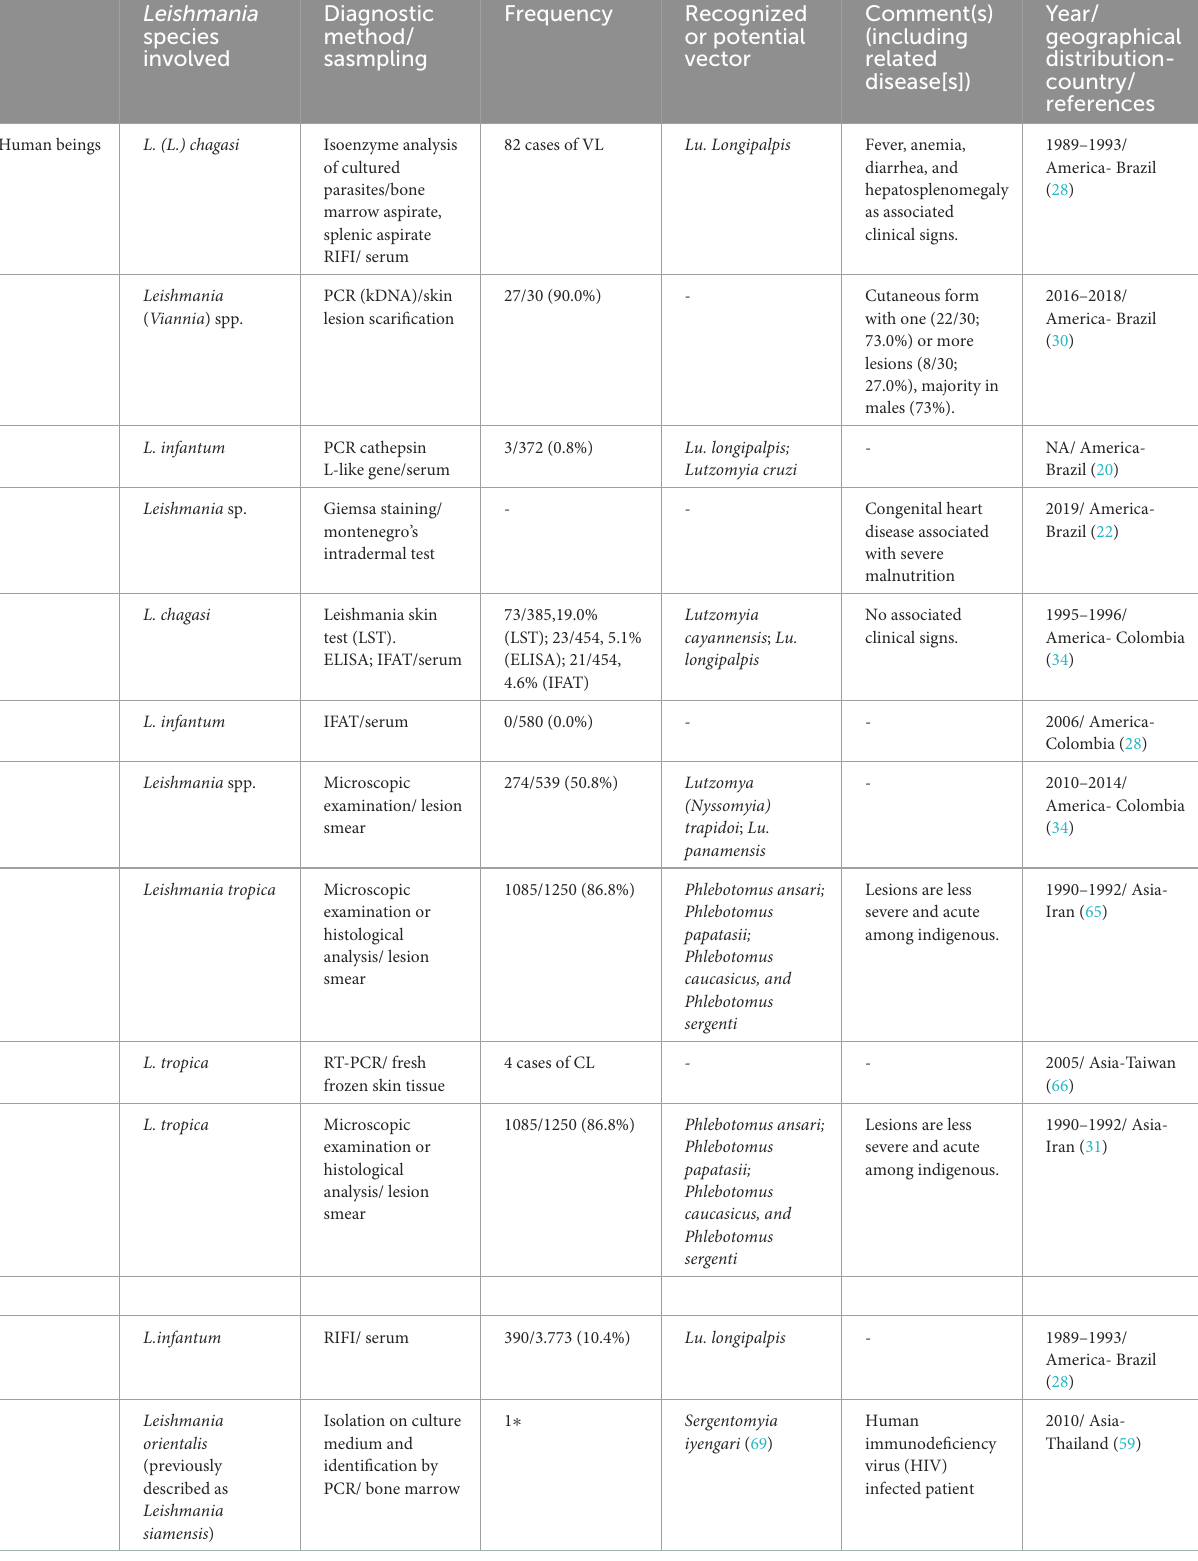
TABLE 1 Leishmania spp. and related vector in indigenous individuals and dogs